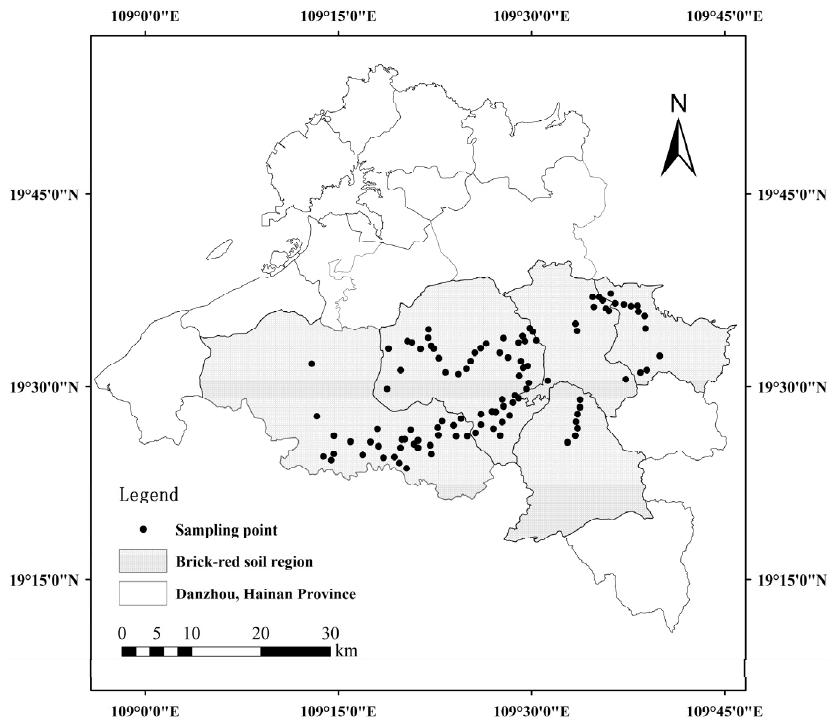
Figure 1. Location of the study area and spatial pattern of soil sampling in Danzhou City, Hainan Province, China.